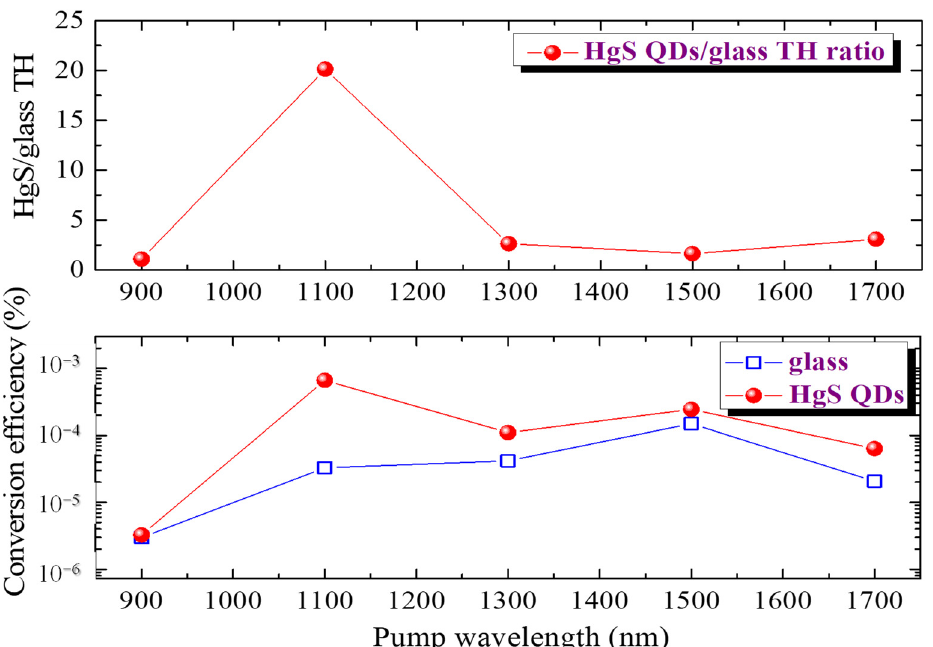
Figure 9. Upper panel shows the ratio of TH yields from the film + plate and pure plate. Bottom panel shows the absolute values of TH conversion efficiencies in the case of film + plate and plate. Reprinted with permission from Ref. [31], 2022, MDPI.